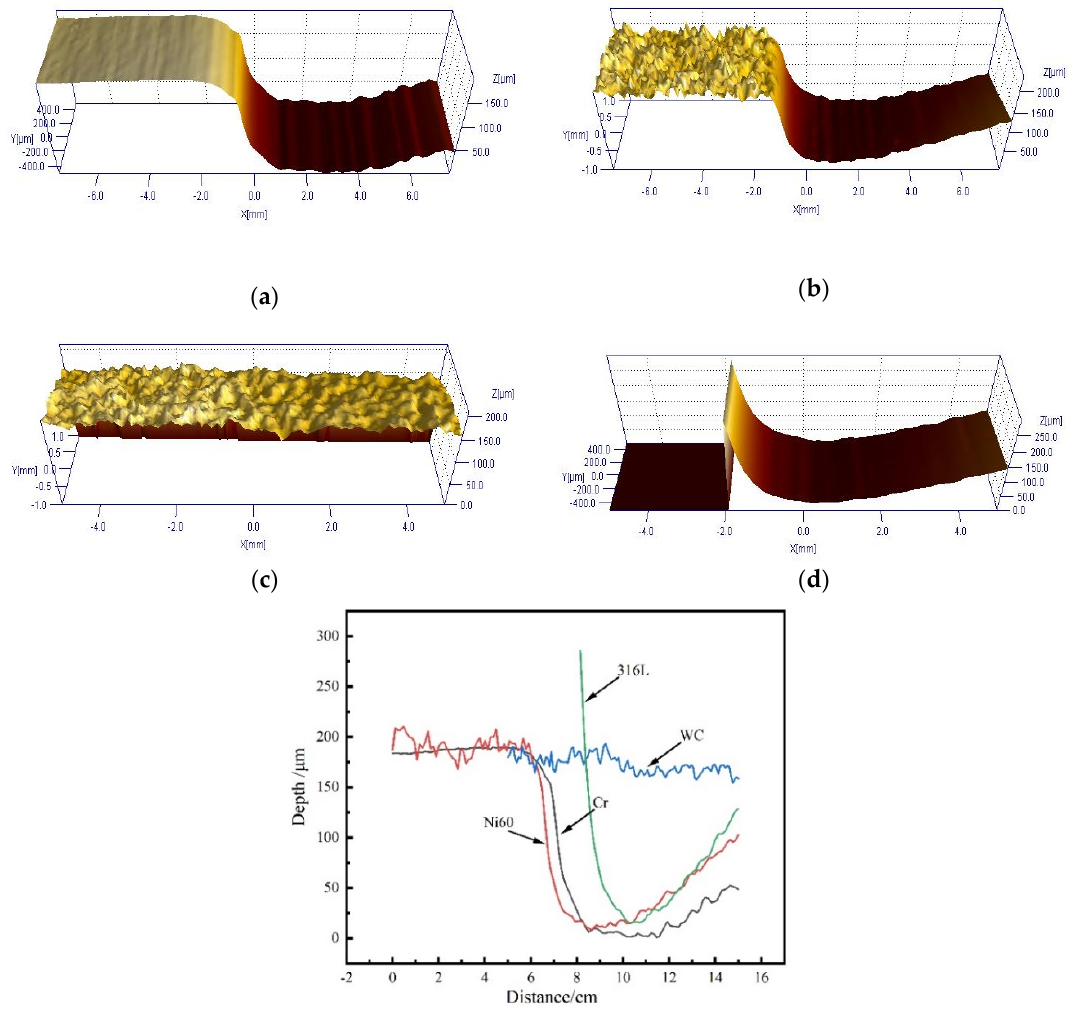
Figure 9. 3D CM images and cross-sectional profiles of hard chrome plating and HVOF coatings. ( a ) hard chrome plating, ( b ) Ni60 coating, ( c ) WC10Co4Cr coating, ( d ) 316L